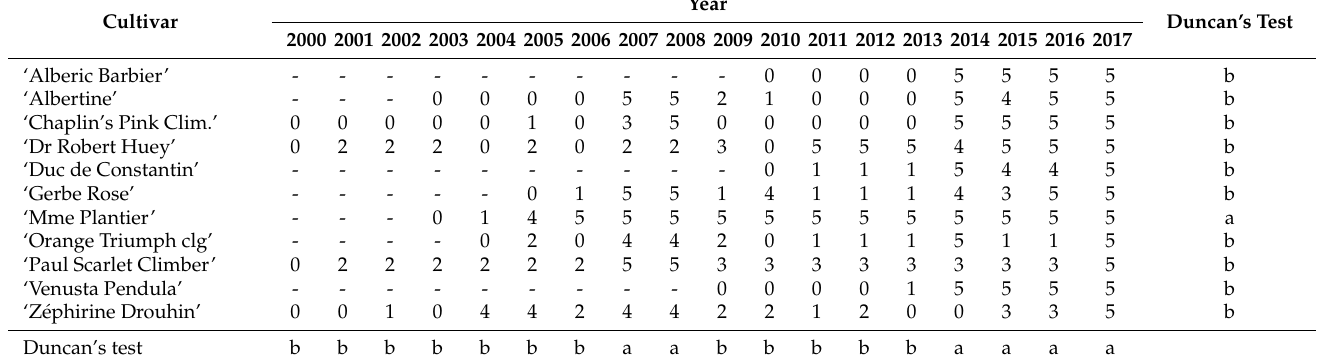
Table 9. The flowering in climber roses evaluated according to the valuation scale: 0—plants fail to bloom; 1—a few poor inflorescences on shoot; 2—<5 inflorescences on 1 m of shoot, weak flowering; 3—with 3–10 flowers in inflorescences, average flowering; 4—>5 inflorescences on 1 m of shoot, abundant and long flowering; 5—abundant and long flowering, the inflorescences densely placed on the plant.